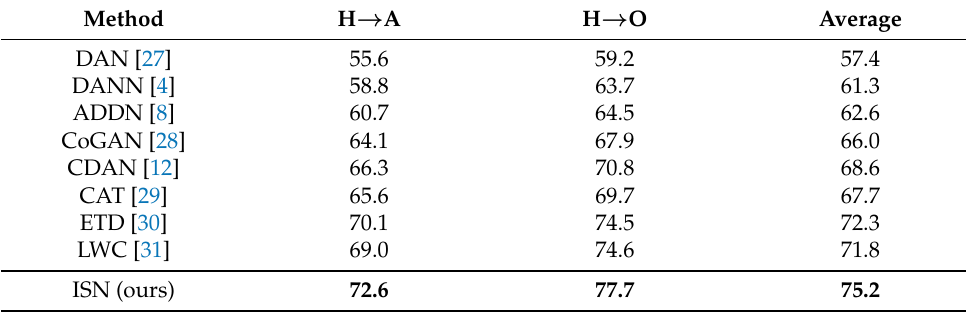
Table 1. Accuracy (%) on BCC (ResNet-101).